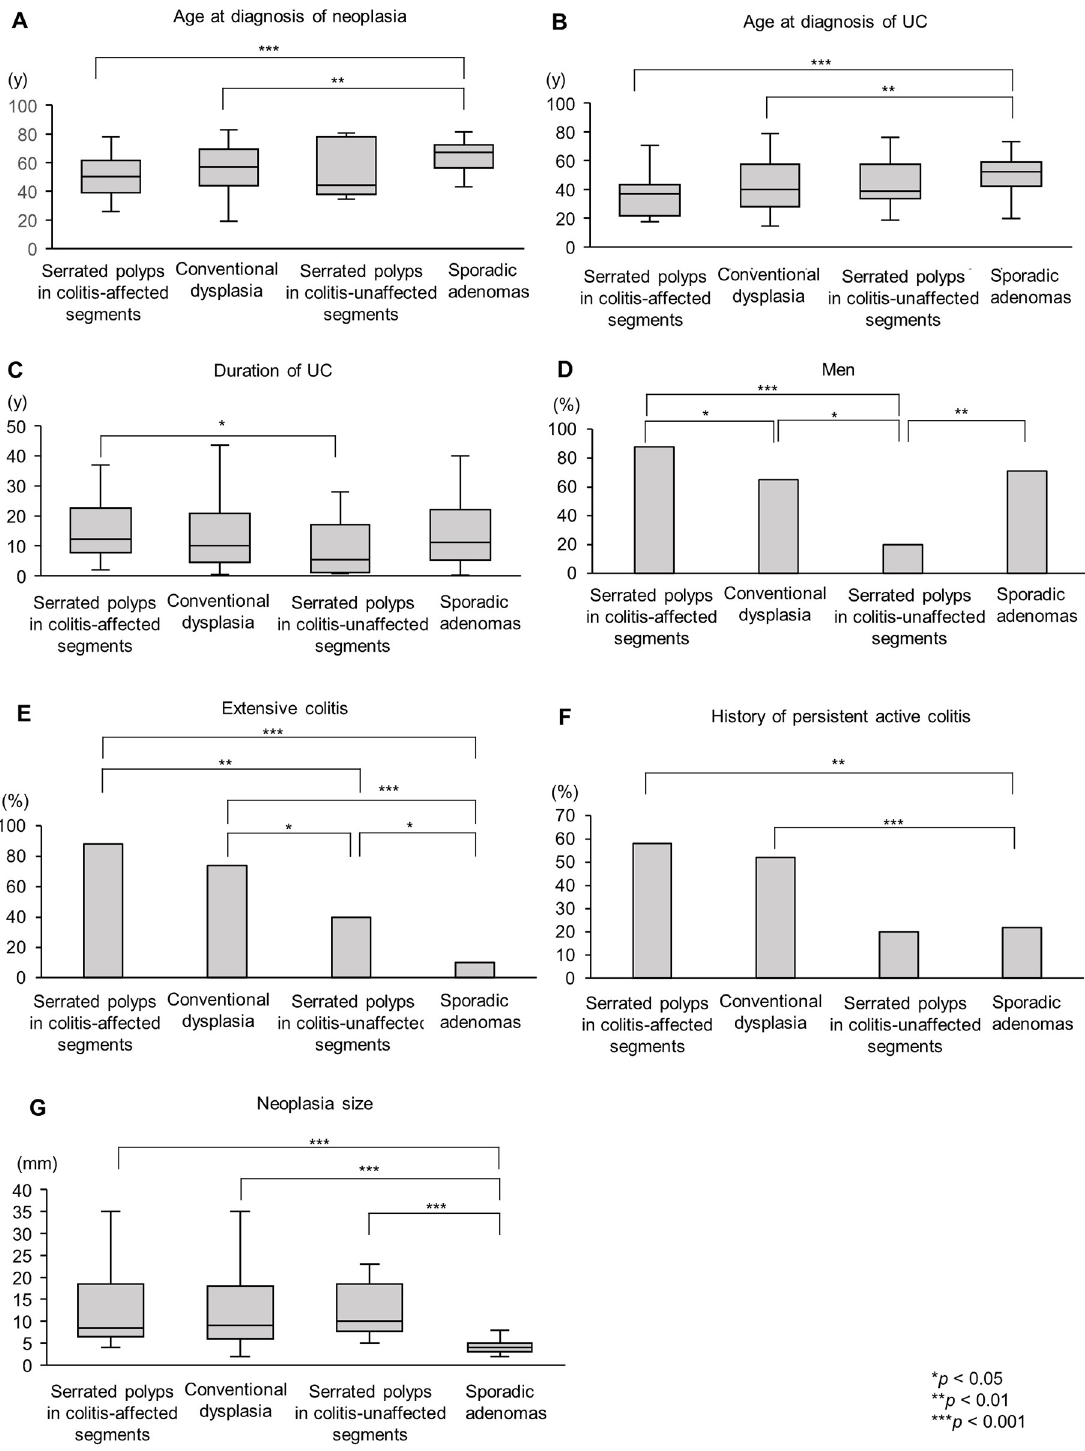
Fig 2. Comparison of the major clinical characteristics among the neoplasia categories. (A) age at diagnosis of neoplasia, (B) age at diagnosis of UC, (C) duration of UC, (D) ratio of men, (E) proportion of extensive colitis, (F) proportion of patients with a history of persistent active colitis, and (G) neoplasia size. Fisher’s exact test and the Wilcoxon rank sum test were used for the statistical analysis. Statistical significance was set at P < 0.05. � P < 0.05, �� P < 0.01, and ��� P < 0.001. UC, ulcerative colitis.